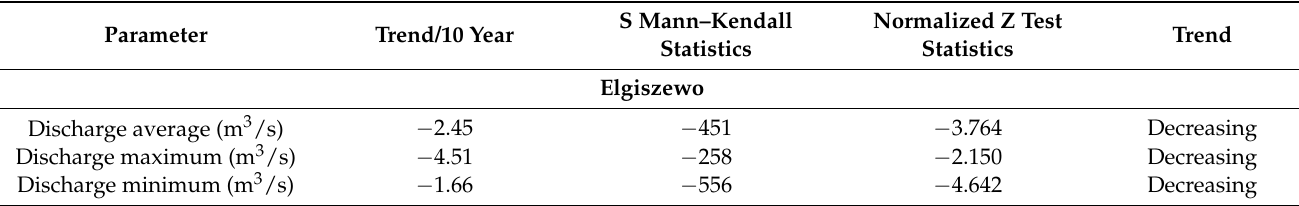
Table 5. Statistical analysis of the hydrological data in Elgiszewo during 1971–2020.